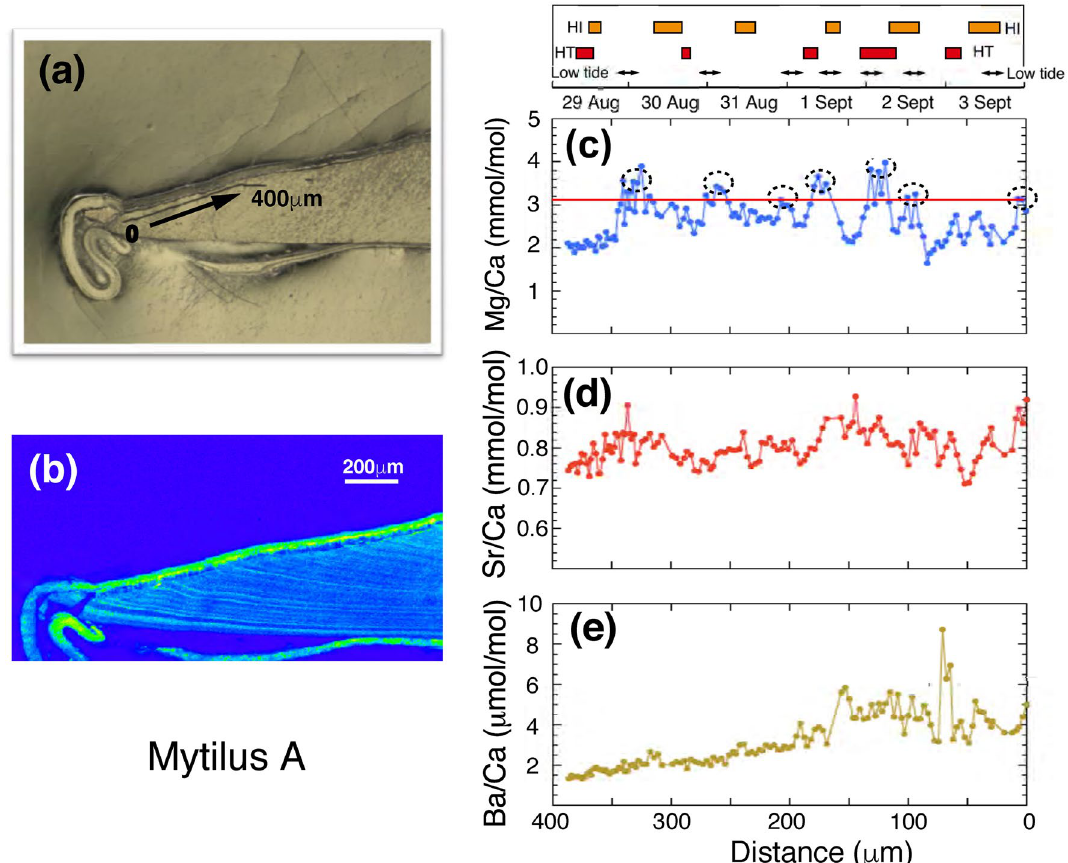
Figure 2. Analyzed position of the mussel shell sample and high-resolution profile of Mg/Ca, Sr/Ca and Ba/ Ca ratios. ( a ) The trace of NanoSIMS analysis on the inner edge of the specimen. ( b ) A sulfur concentration map of the inner edge of the specimen measured by an EPMA. The approximate date is given in the top. ( c ) High-resolution profile of Mg/Ca ratios along the trace. A red line shows a threshold value. Ovals indicate values higher than the threshold. ( d ) High-resolution profile of Sr/Ca ratios along the trace. ( e ) High-resolution profile of Ba/Ca ratios along the trace. The simplified scales of the higher insolation (HI), higher temperature (HT), and lower tide period (double-edged arrow) are shown above the profiles for the references of environmental factors. The periods of HI, HT, and lower tide were certified based on the threshold values in Figure